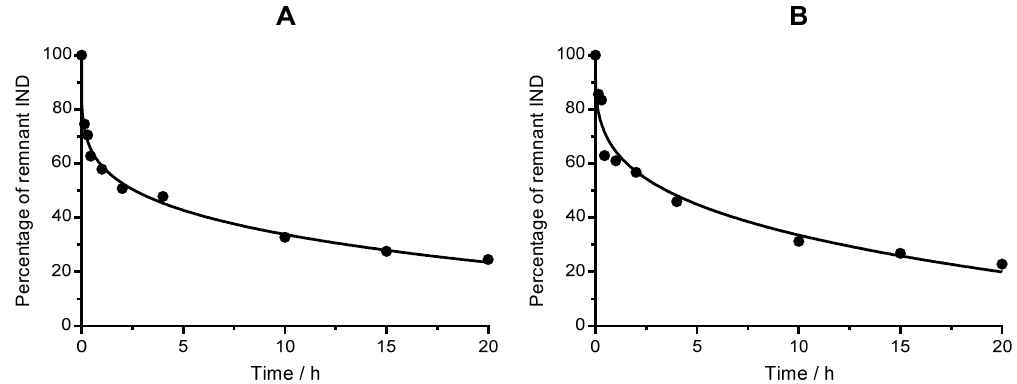
Figure 4. Time-dependent release kinetics of IND from nanoemulsions in Hepes buffer. Solid line is the fitting of the Korsmeyer-Peppas model to the experimental points. ( A ) High energy nanoemulsion, and ( B ) Low energy nanoemulsion.